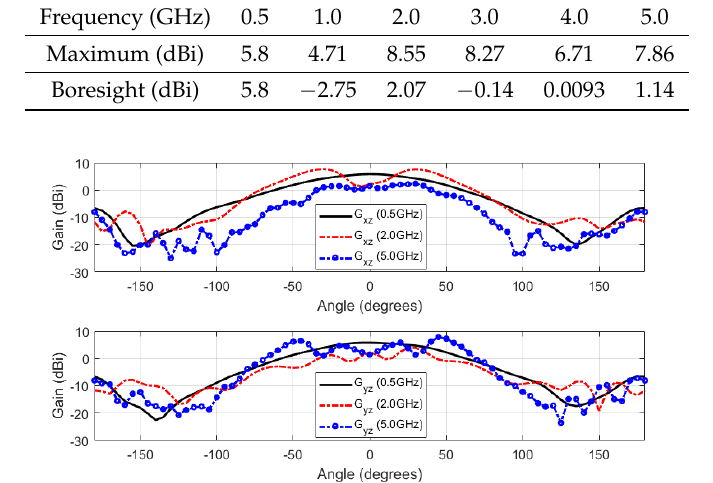
Figure 6. Measured total gain at 0.5, 2 and 5 GHz, plotted in two principal elevation planes, xz and yz , where z is along the antenna’s boresight.